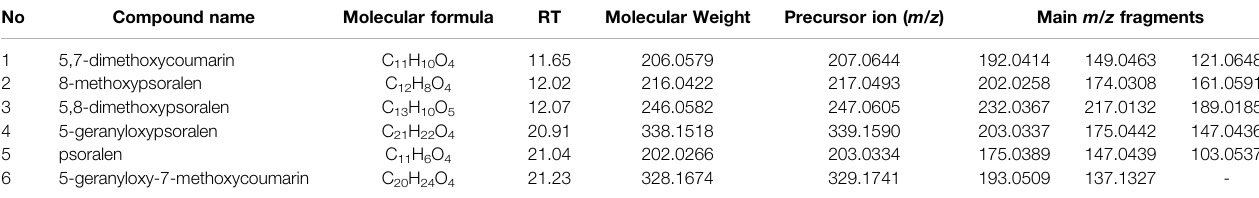
TABLE 1 | The identi fi cation of the metabolites higher in Citrus latifolia than Citrus limon by LC-QTOF-MS/MS analysis in the coumarin